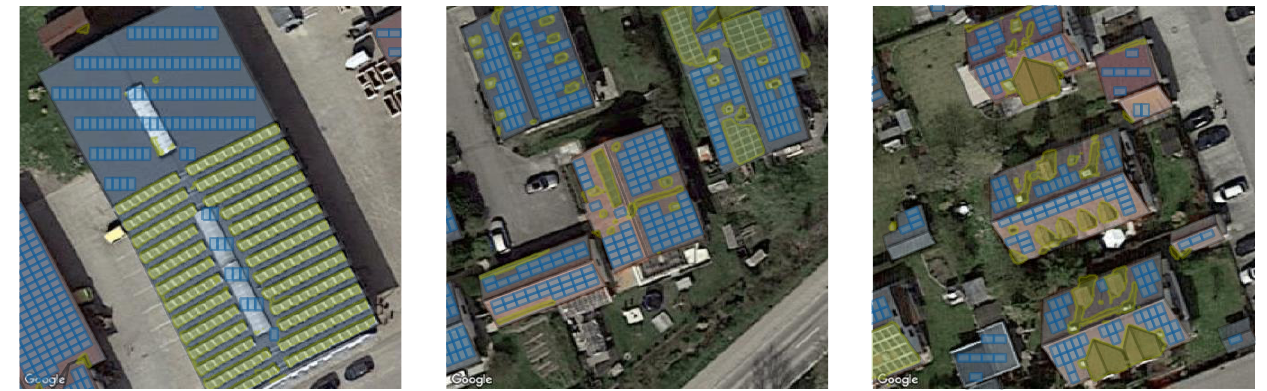
Figure 11. Examples of roof segments (light gray), roof superstructures (green), and module place- ment (blue) in the study